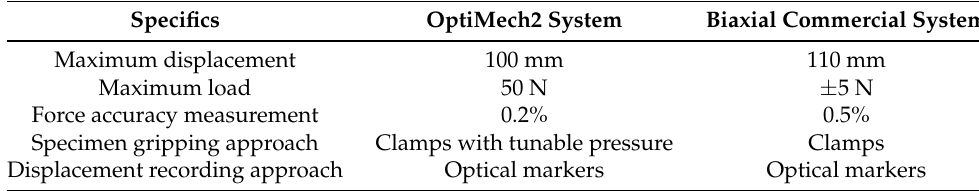
Table 1. Table for the comparison of OptiMech2 system specifics with a commercial device